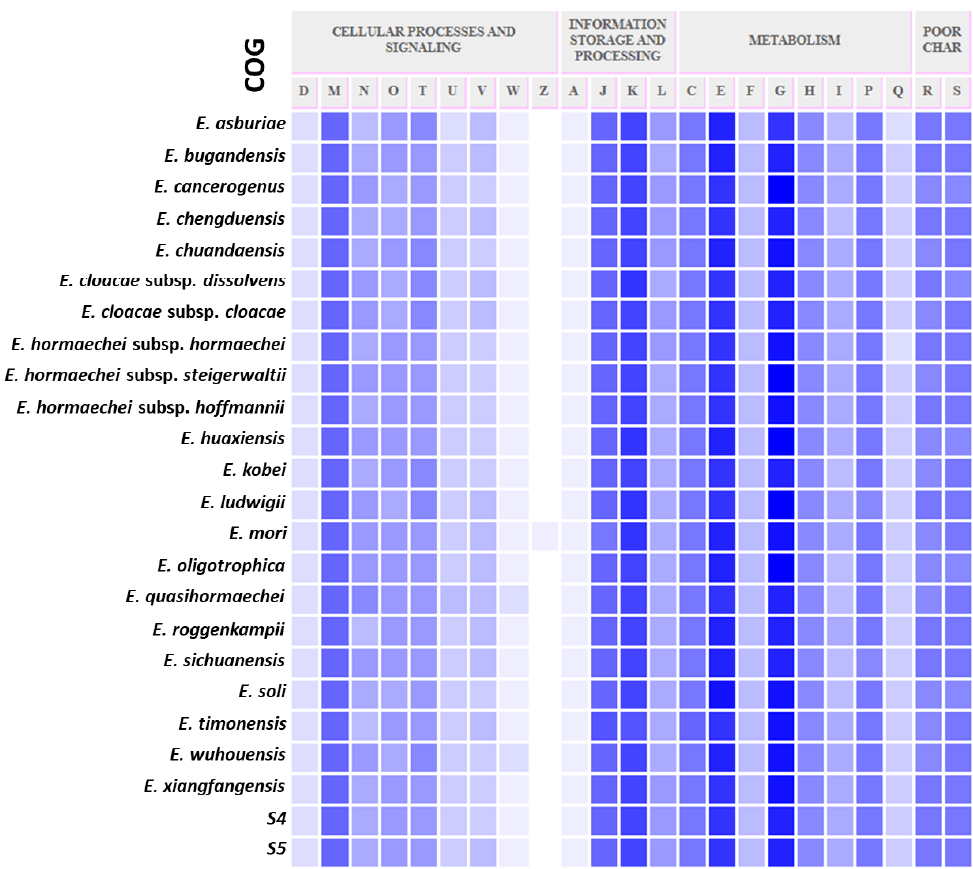
Figure 3. A heatmap showing clusters of orthologous genes (COGs) for isolates S4, S5, and a representative of all validly published Enterobacter species (see Materials and Methods for full species list and accession numbers). The COGs covered cellular processing and signaling (D: cell cycle control, cell division, chromosome partitioning; M: cell wall/membrane/envelope biogenesis; N: cell motility; O: post-translational modification, protein turnover, and chaperones; T: signal transduction mechanism; U: intracellular trafficking, secretion, and vesicular transportation; V: defense mechanisms; W: extracellular structures; Z: cytoskeleton), information storage and processing (A: RNA processing and modification; J: translation, ribosomal structure, and biogenesis; K: transportation; L: replication, recombination, and repair), metabolism (C: energy production and conversion; E: amino acid transport and metabolism; F: nucleotide transport and metabolism; G: carbohydrate transport and metabolism; H: coenzyme transport and metabolism; I: lipid transport and metabolism; P: inorganic ion transport and metabolism; Q: secondary metabolites biosynthesis, transport, and catabolism), as well as the poorly characterized (R and S).